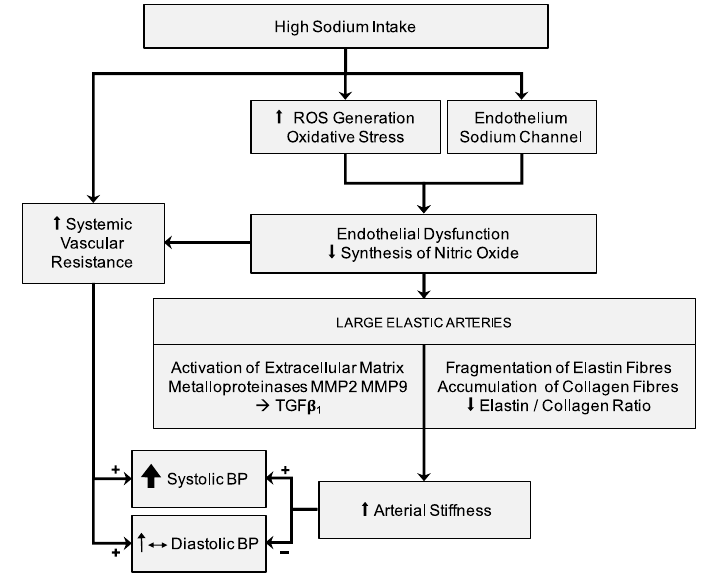
Figure 1. Relationship between high salt intake with diet, blood pressure, and arterial stiffness. Abbreviations: BP, blood pressure; MMP, matrix metalloproteinases; ROS, reactive oxygen species; TGF, transforming growth factor.